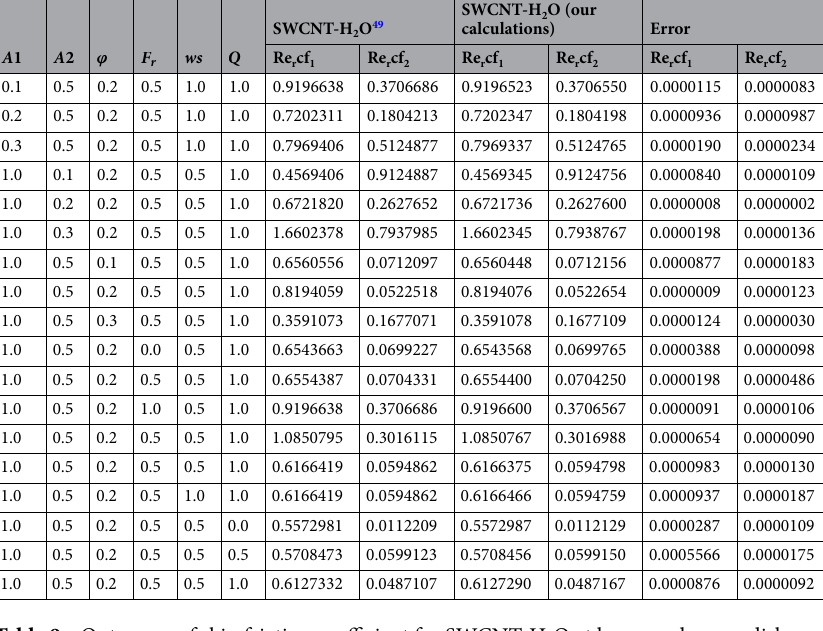
Table 9. Outcomes of skin friction coefficient for SWCNT-H 2 O at lower and upper disks.